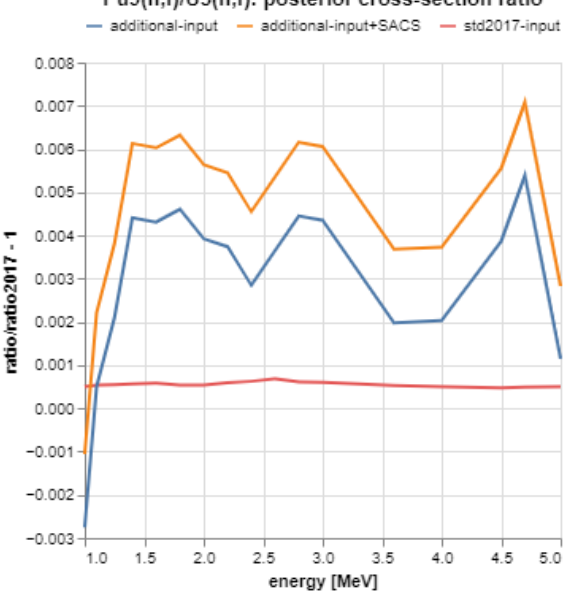
Figure 4: Evaluated 239 Pu(n,f) / 235 U(n,f) cross-section ra- tio relative to the IAEA STD 2017 cross-section ratio [3].